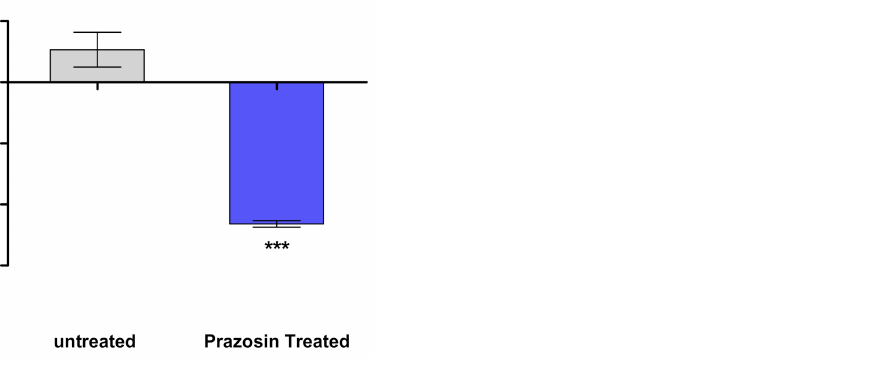
Figure 3. Prazosin downregulated the expression of LuxR homolog QS receptor SdiA. Prazosin significantly reduced the expression of Salmonella sdiA gene (*** = p < 0.0001).